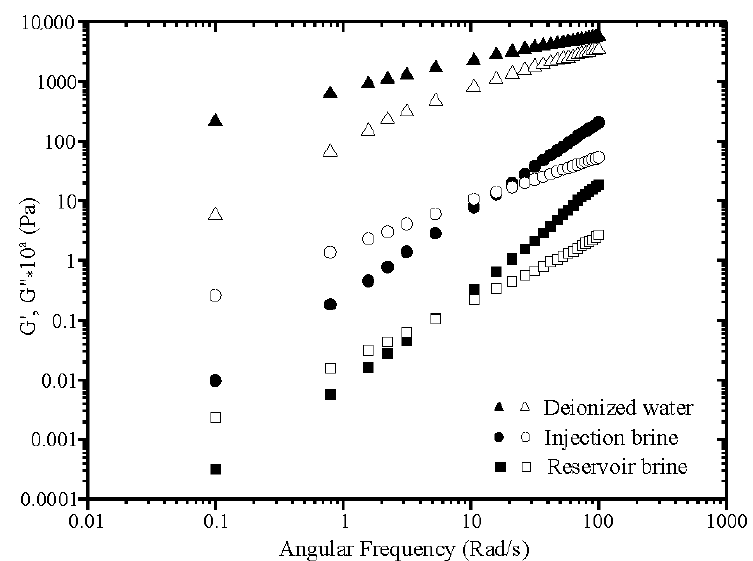
Figure 8. Mechanical spectra of xanthan solutions in DW, IW and RW (filled symbol G’, open symbol G”). (To avoid overlapping, data have been vertically shifted by 10 a with a = 0, 1,